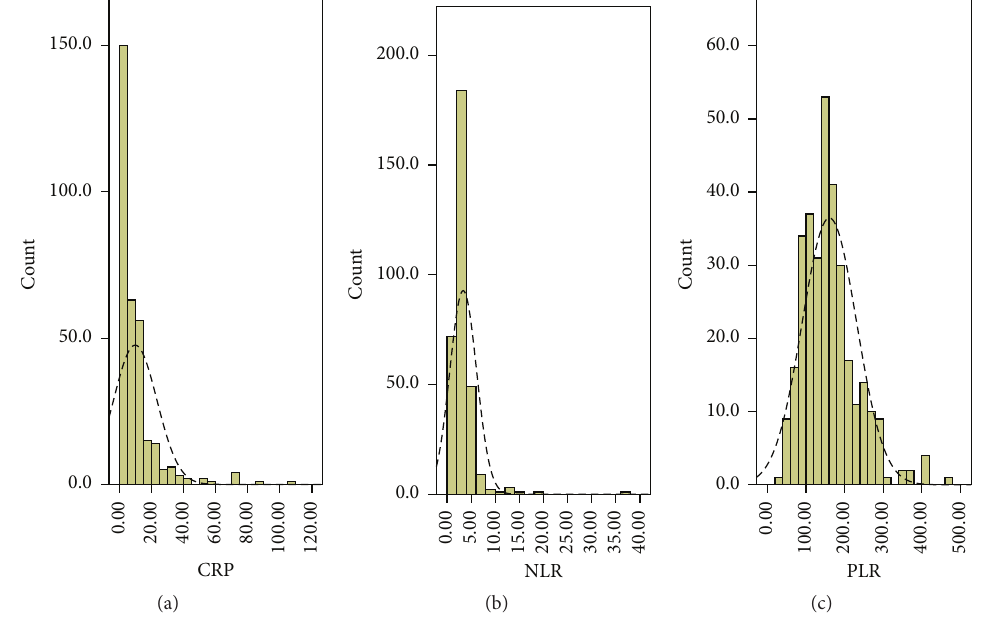
Figure 1: The histograms of the CRP (a), NLR (b), and PLR (c).